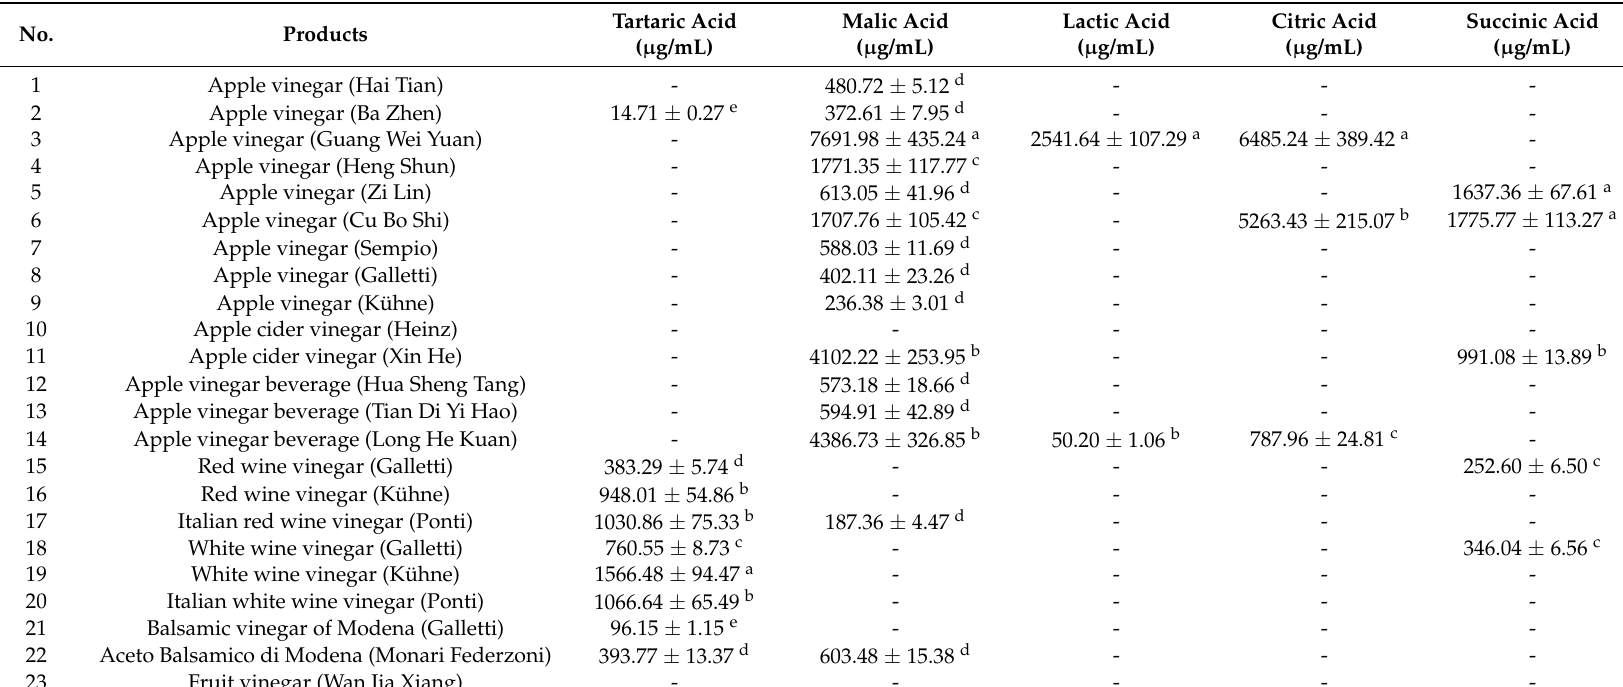
Table 4. Main organic acids and their contents in 23 fruit